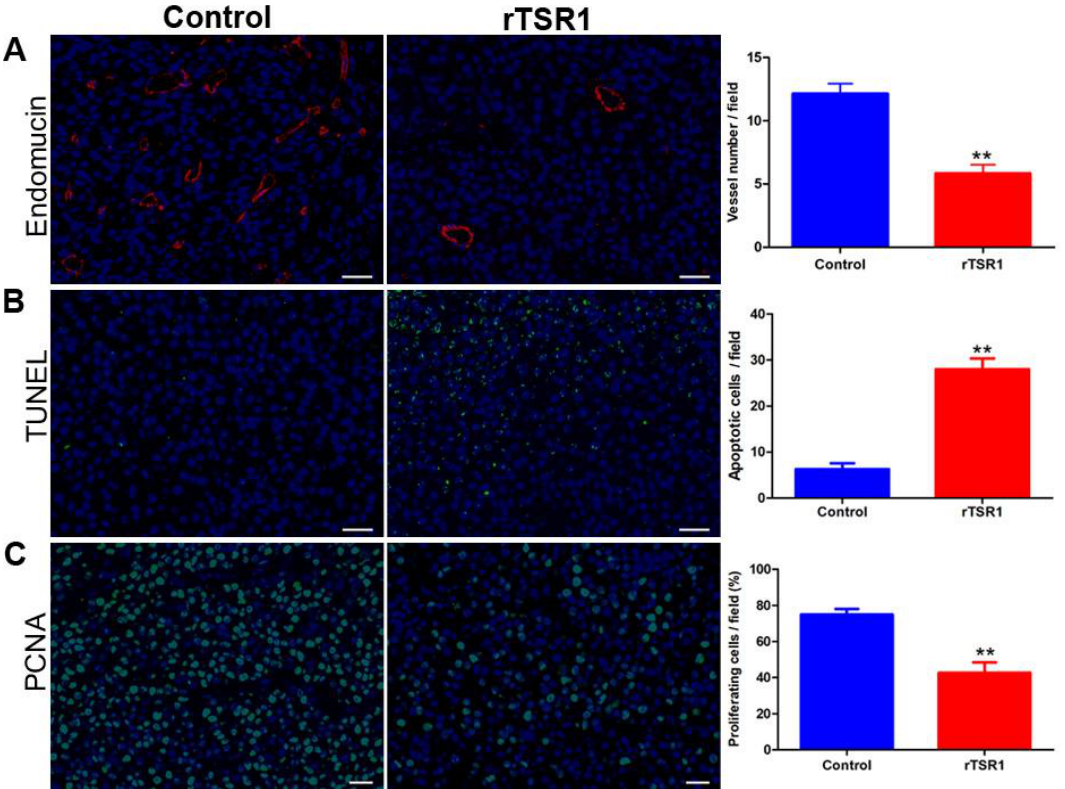
Figure 3. The rTSR1 suppressed angiogenesis and cell proliferation but induced apoptosis in tumors. Tumor paraffin sections were probed for microvessel density, tumor cell proliferation, and apoptosis through immunofluorescence staining, using ( A ) anti-endomucin, ( B ) TUNEL staining, and ( C ) anti-PCNA (Proliferating cell nuclear antigen) respectively. The corresponding quantification of the staining is presented in the bar graph on the right. The percentage of proliferating cells/field is the ratio of the nuclear PCNA-positive cells to the total number of nuclei in the field. Scale bar: 200 μm. Corresponding quantifications are presented in the bar graph on the right. Data represent the mean ± SD of four fields per section, four sections per tumor, and two tumors per group. Statistical analysis was performed by Student’s t test. ** p < 0.01.